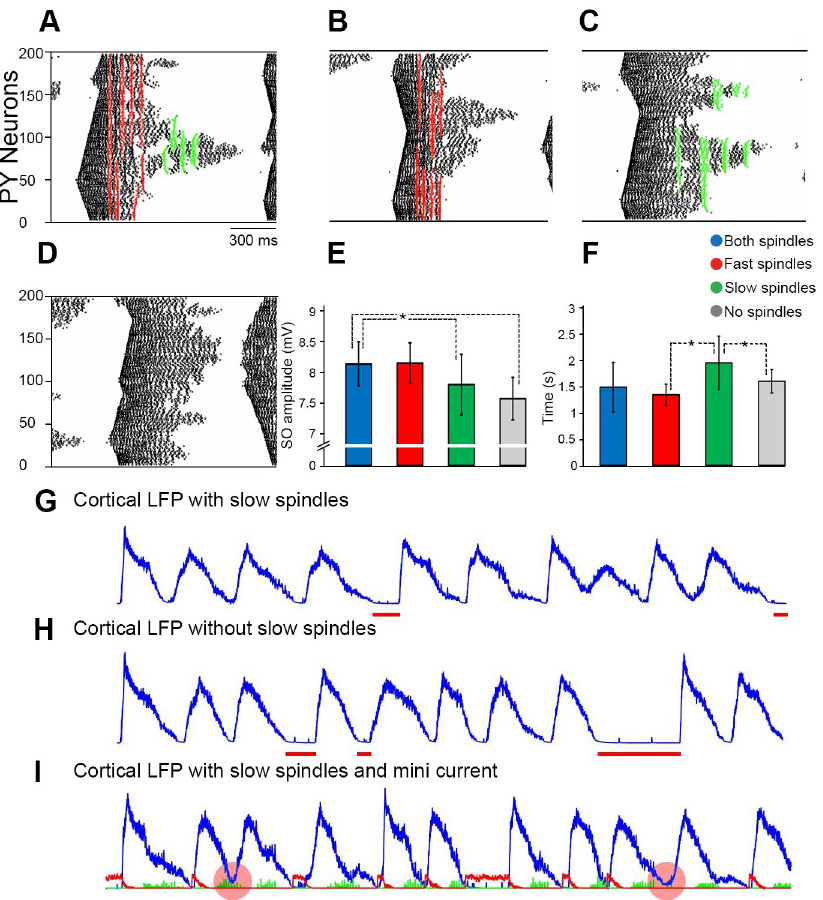
Fig 5. The influence of different thalamic inputs on the SO cycle dynamics. A , PY spike raster plots for one SO cycle with both fast and slow spindles inputs; B , with only fast spindles (slow spindles were blocked). PY firing rate is relatively increased by fast spindle input (red); C , with only slow spindles (fast spindles were blocked). PY firing rate is relatively increase by slow spindle input (green). D , without spindle input (both fast and slow spindles were blocked). E , Average cortical LFP amplitude in the presence of both fast and slow spindles (blue), fast spindles only (red), slow spindles only (green), and without spindles (gray). Average SO amplitude is lowest when spindles are absent. Asterisks show significant difference between the amplitudes (two sample t-test with � P < .01). F , Average SO cycle duration dependent upon presence of spindles. Duration was longest for the presence of slow spindles. Error bars describe standard deviation between SO cycles. Asterisks show significant difference between the SO cycle duration ( � P < .01). G , Resultant cortical LFP when the input of miniature synaptic current was reduced, but slow spindles were still generated by the model. The horizontal red bars indicate periods of increased down state duration due to weak mini synaptic current. H , Same as for G, however slow spindles are blocked. The down state durations are on average longer than when slow spindles are present (G). I , The cortical LFP with the input of miniature synaptic current (red) and slow spindles (green). The red circles indicate SO initiated by slow spindles without mini